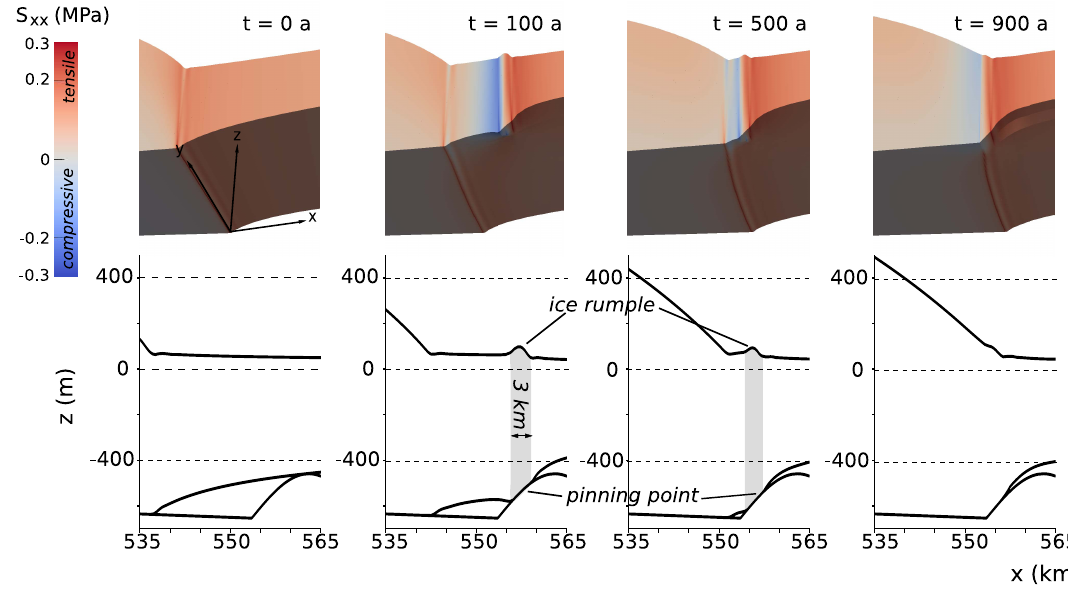
Fig. 11. The top series show 3-D snapshots for experiment A (after t = 0, 100, 500, 900 a), superimposed with the longitudinal deviatoric stresses. Each snapshot is associated in the bottom series with its corresponding (x,z) plane view of the flowline at y = 50 km. An ice rumple forms on the upper surface under the effect of the contact between the pinning point and the ice lower surface. Both are vertically aligned over all the simulation until both grounded parts merge together.